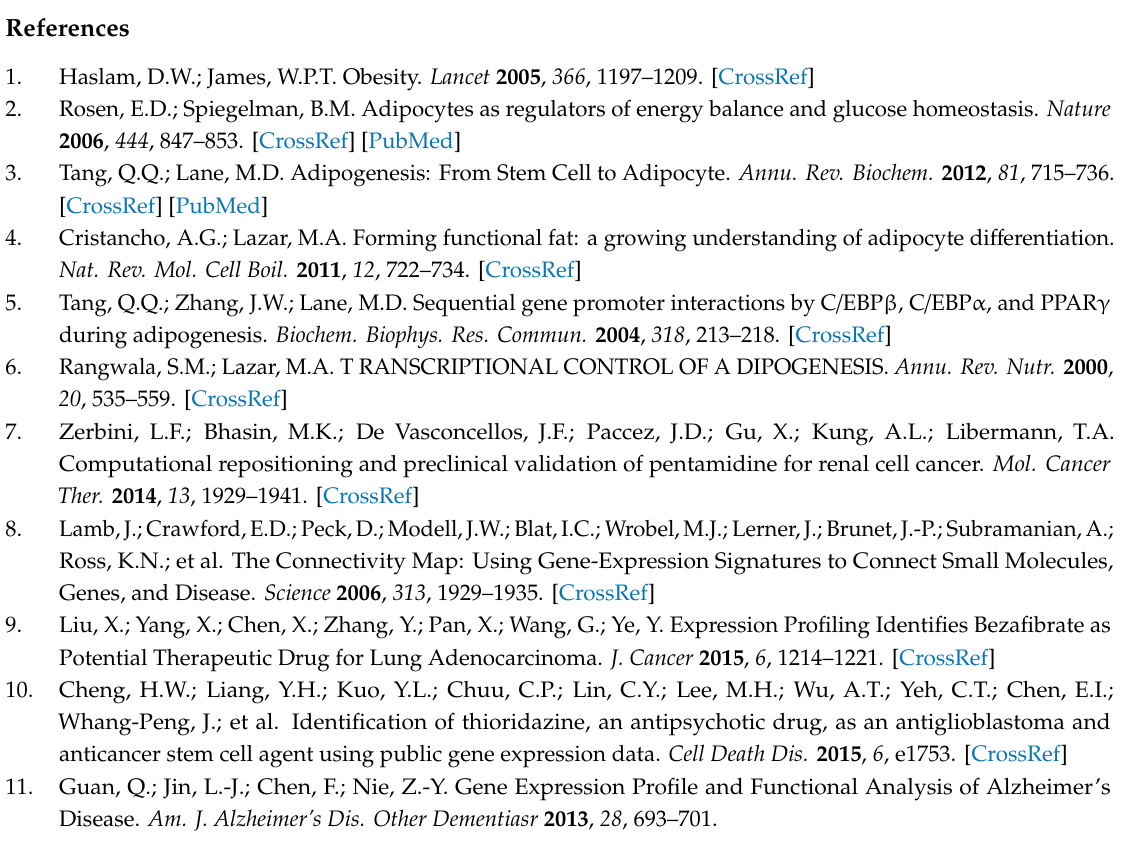
Supplementary Materials: The following are available online, Table S1: The up-regulated expression genes in C3H10T1 / 2 and 3T3-L1 cells during adipogenic di ff erentiation, Table S2: The down-regulated expression genes in C3H10T1 / 2 and 3T3-L1 cells during adipogenic di ff erentiation, Table S3: The transformed A ff ymetrix probe-sets from the up-regulated expression genes list, Table S4: The transformed A ff ymetrix probe-sets from the down-regulated expression genes list, Table S5: Primers used for